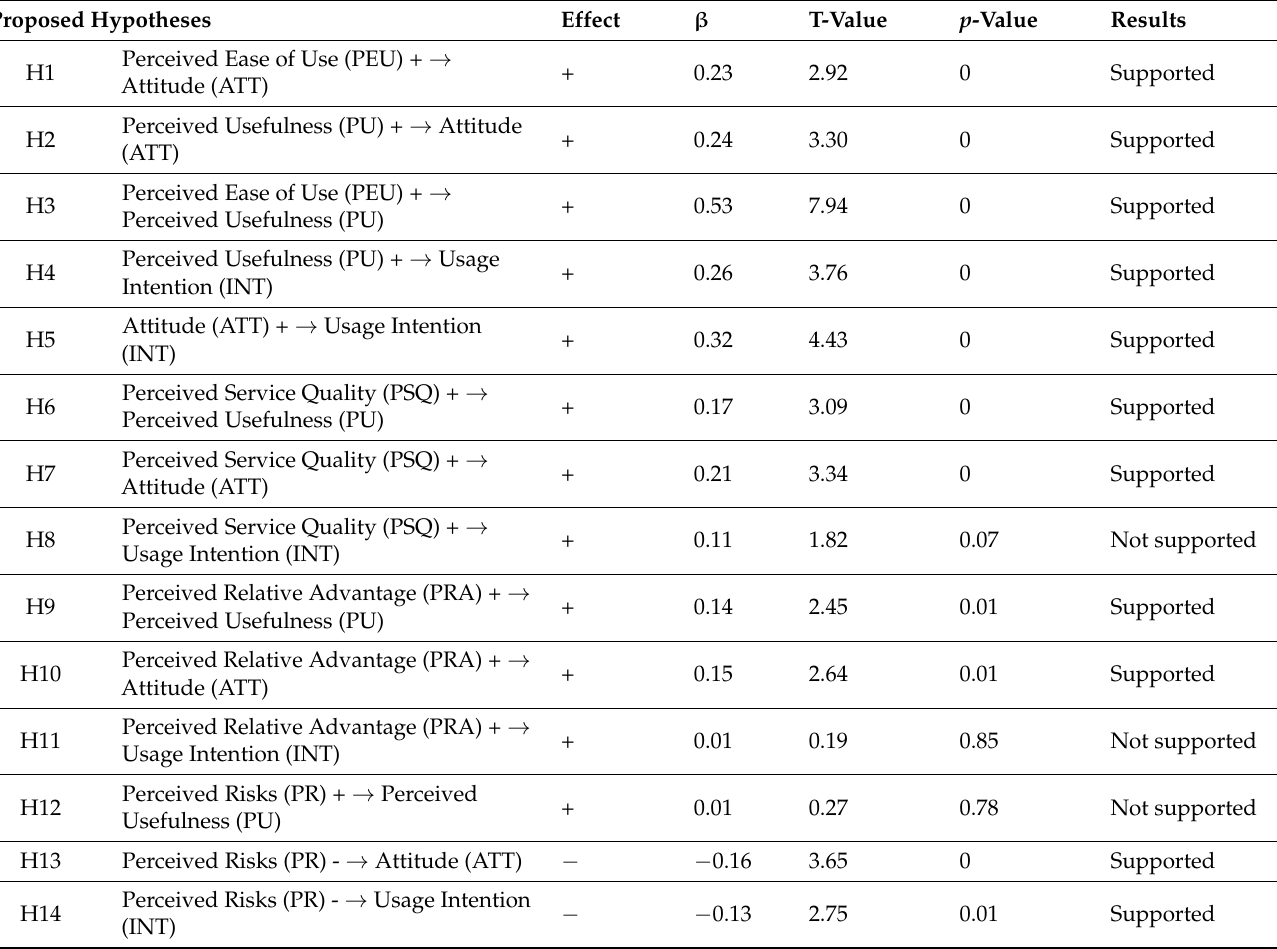
Table 9. Structural model evaluation